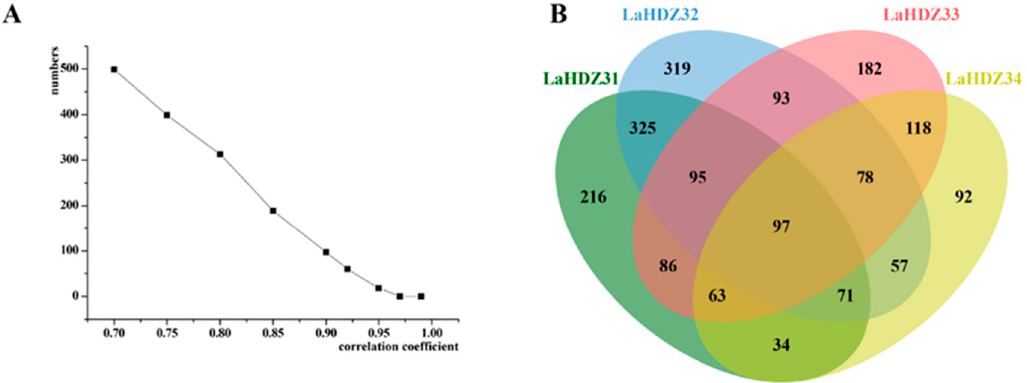
Figure 9. Pearson correlation analysis of related genes, based on the transcriptomic analysis of Larix kaempferi . ( A ) Number of genes against correlation coefficients; ( B ) Venn diagram of the 97 genes associated with LaHDZ31–34 expression; r = 0.9.